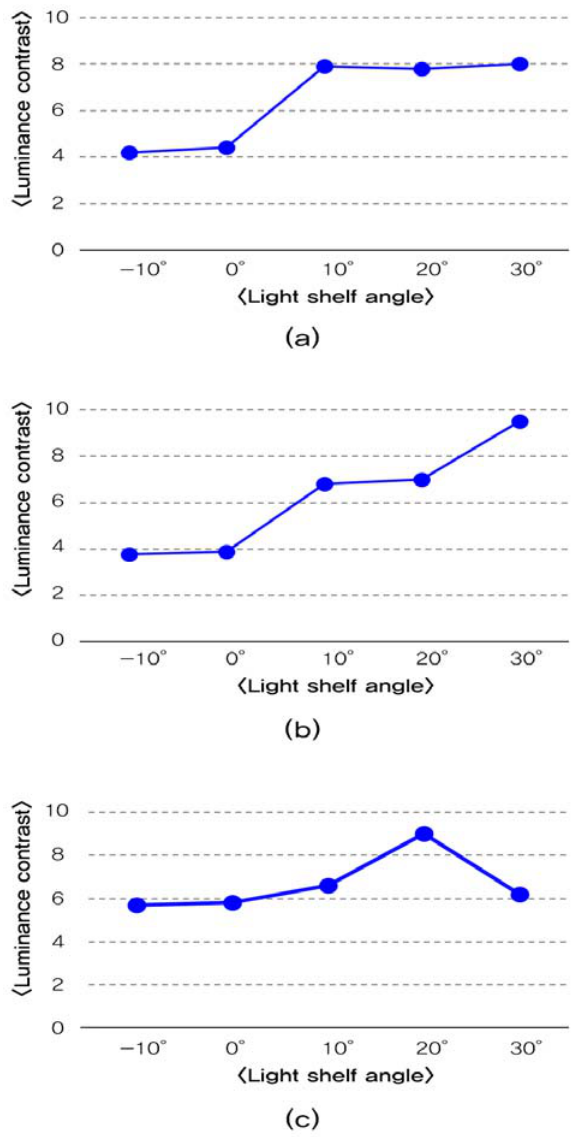
Figure 10. Analysis of luminance contrast per light shelf angle: ( a ) per light shelf angle in summer; ( b ) luminance contrast per light shelf angle in middle season; ( c ) luminance contrast per light shelf angle in winter. Table 11 Analysis of light shelf variables and lighting energy consumption to improve energy saving and visual environment.